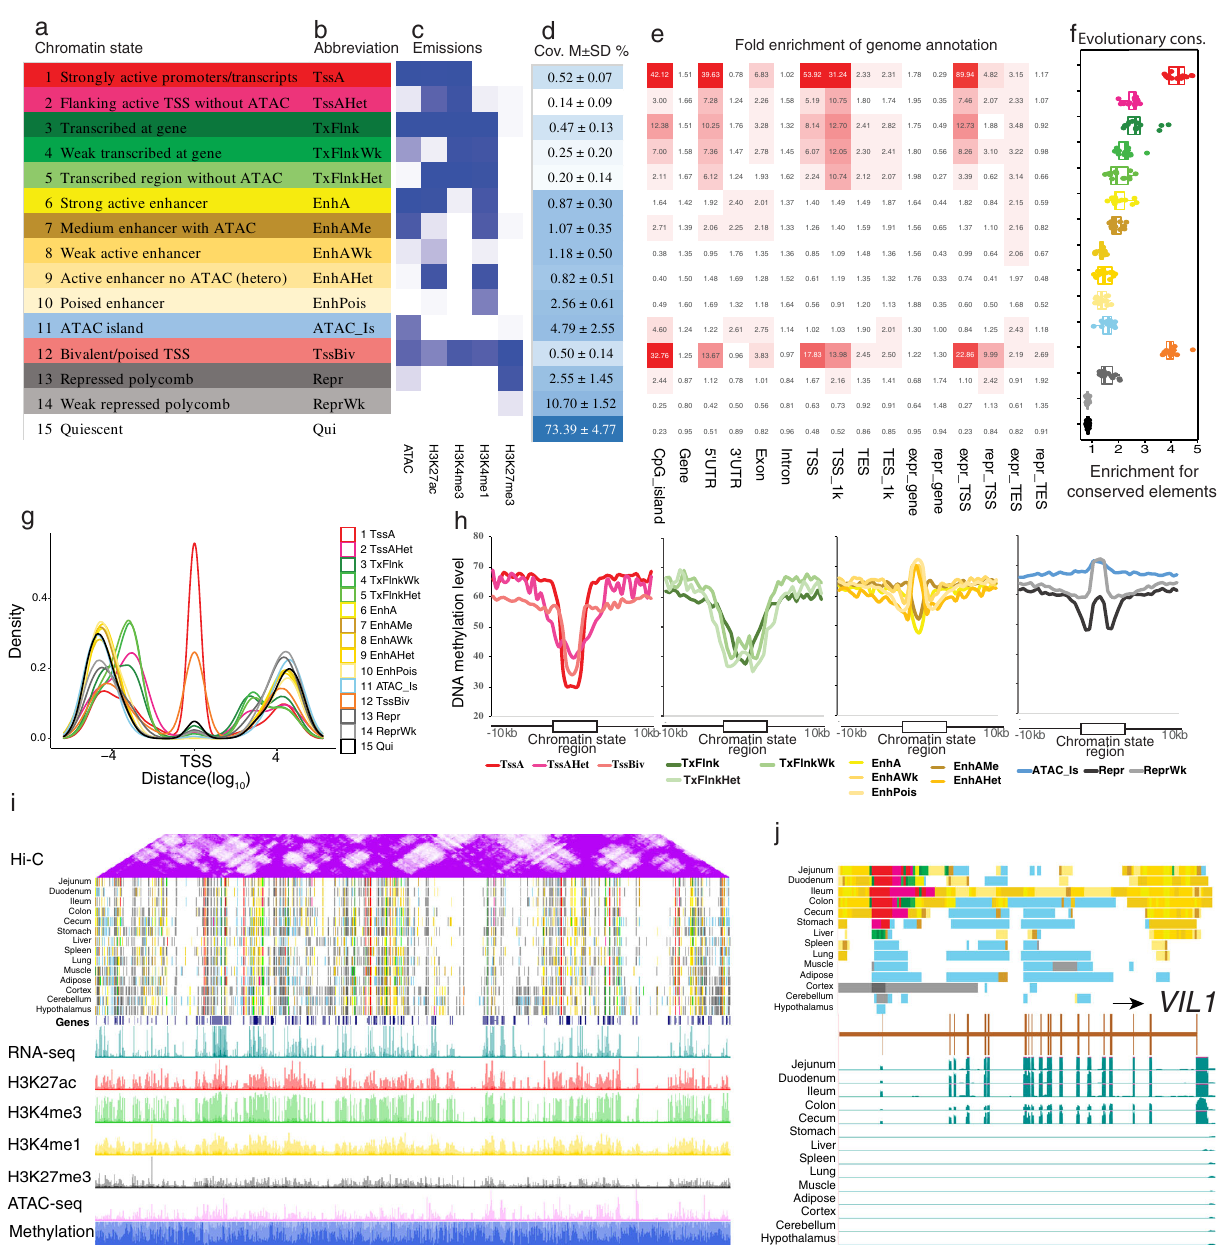
Fig. 2 Chromatin landscape across 14 tissues. a , b De fi nitions and abbreviations of 15 chromatin states. c Emission probabilities of individual epigenetic marks for each chromatin state. The color from white to deep blue indicates emission probability (0 – 1). d Genomic coverage of each chromatin state. M ± SD mean ± standard deviation. e Average enrichment of chromatin states for genomic annotations, including CpG islands, genes, TSS/TES_1K (±1 kb around TSS and TES), expressed genes (TPM ≥ 0.1), and repressed genes (TPM < 0.1) in each tissue. f Fold enrichments of chromatin states for non-coding mammalian conserved elements from Genomic Evolutionary Rate Pro fi ling (GERP). Whiskers show 1.5× interquartile range. Each data point represents one of 14 different tissues. g Density of each chromatin state in positions relative to gene TSS. h Average methylation level of chromatin states in jejunum. i Hi- C (250 kb resolution), predicted chromatin states, epigenetic signal, and normalized methylation level in jejunum across chromosome 7. j Chromatin state landscape and mRNA expression at VIL1 locus (chr15:120,459,825-120,493,312, susScr11) across 14 tissues. Vertical scale of UCSC tracks shows normalized signal from 0 to 200 for